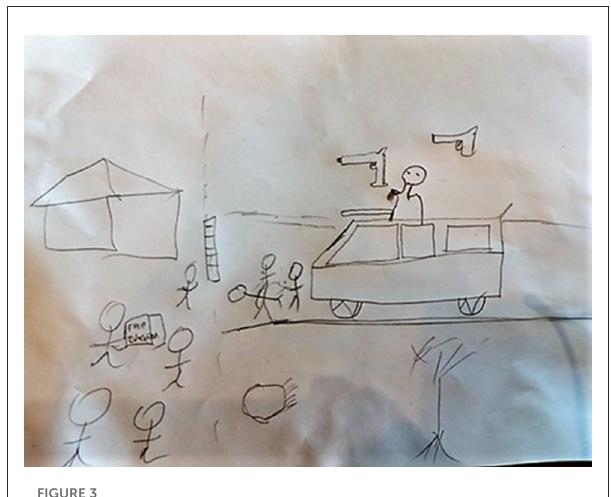
FIGURE3 Dream drawing about protest and bondage in student